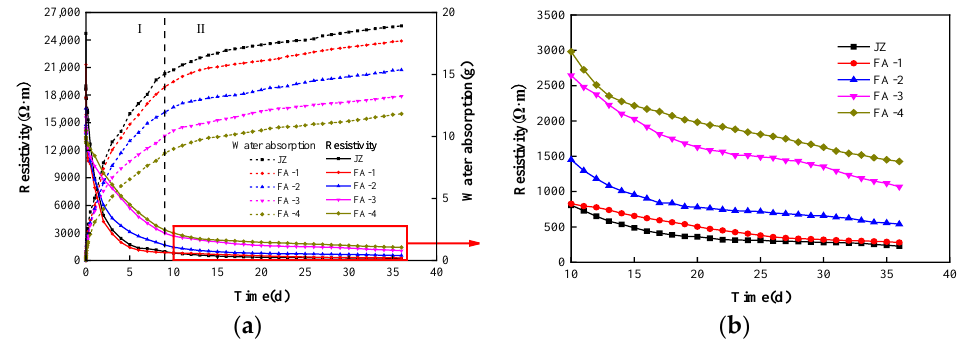
Figure 5. Changes in water absorption and resistivity of cement mortar with different FA contents over time: ( a ) Macroscopic damage; ( b ) Partially enlarged drawing.